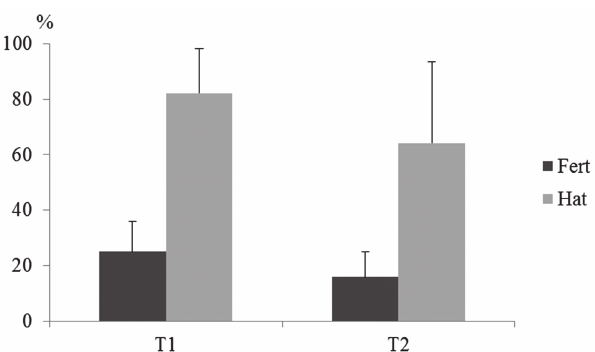
Fig. 2 . Mean and standard deviation of the Fertilization Rate (Fert) and Hatching Rate (Hat) of Colossoma macropomum semen frozen with two extenders (T1 - Solution 1 and T2 - Solution 2). Evaluated using the Kruskal-Wallis non- parametric